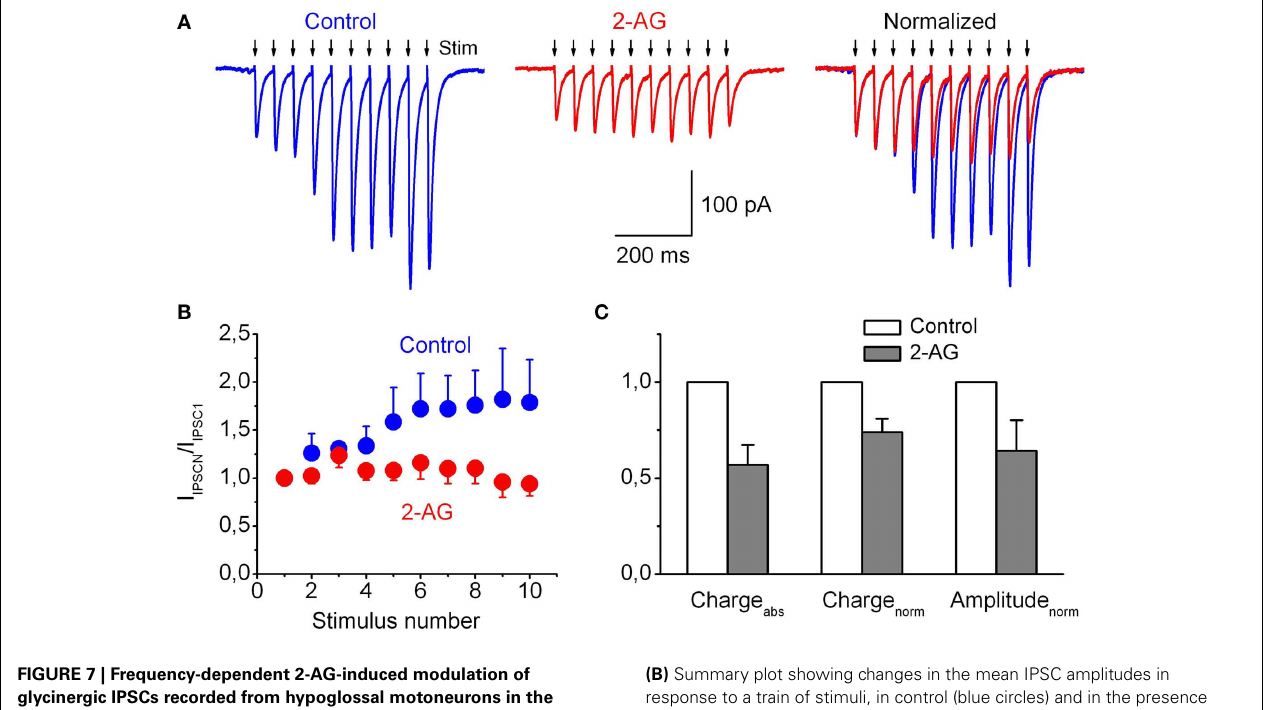
FIGURE 7 | Frequency-dependent 2-AG-induced modulation of glycinergic IPSCs recorded from hypoglossal motoneurons in the CB1R-knockout mouse brainstem slice. (A) Representative averaged trace of five individual traces of IPSC induced by presynaptic stimulation (20Hz) in control ( left ) and in the presence 2-AG (5 μ M; middle ).The same traces are normalized to the first peak amplitude ( right ).